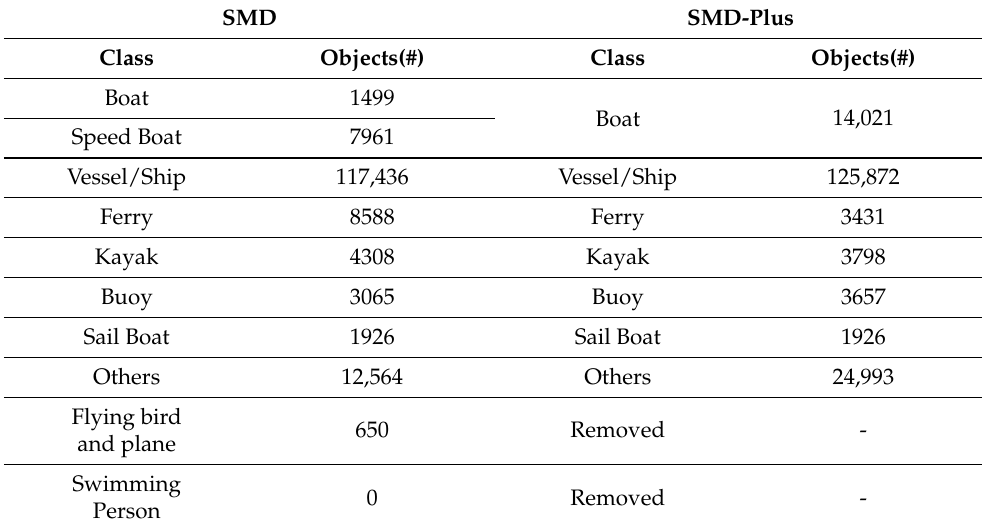
Table 1. The number of objects in each class label for the original SMD and the SMD-Plus. SMD